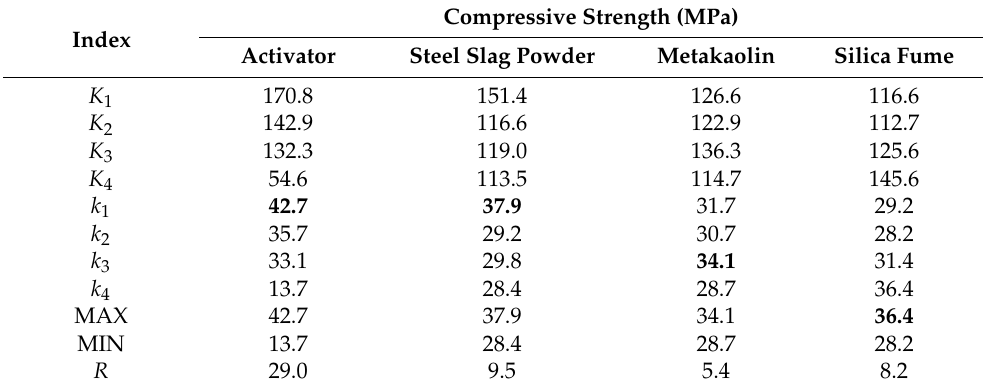
Table 6. Range analysis of compressive